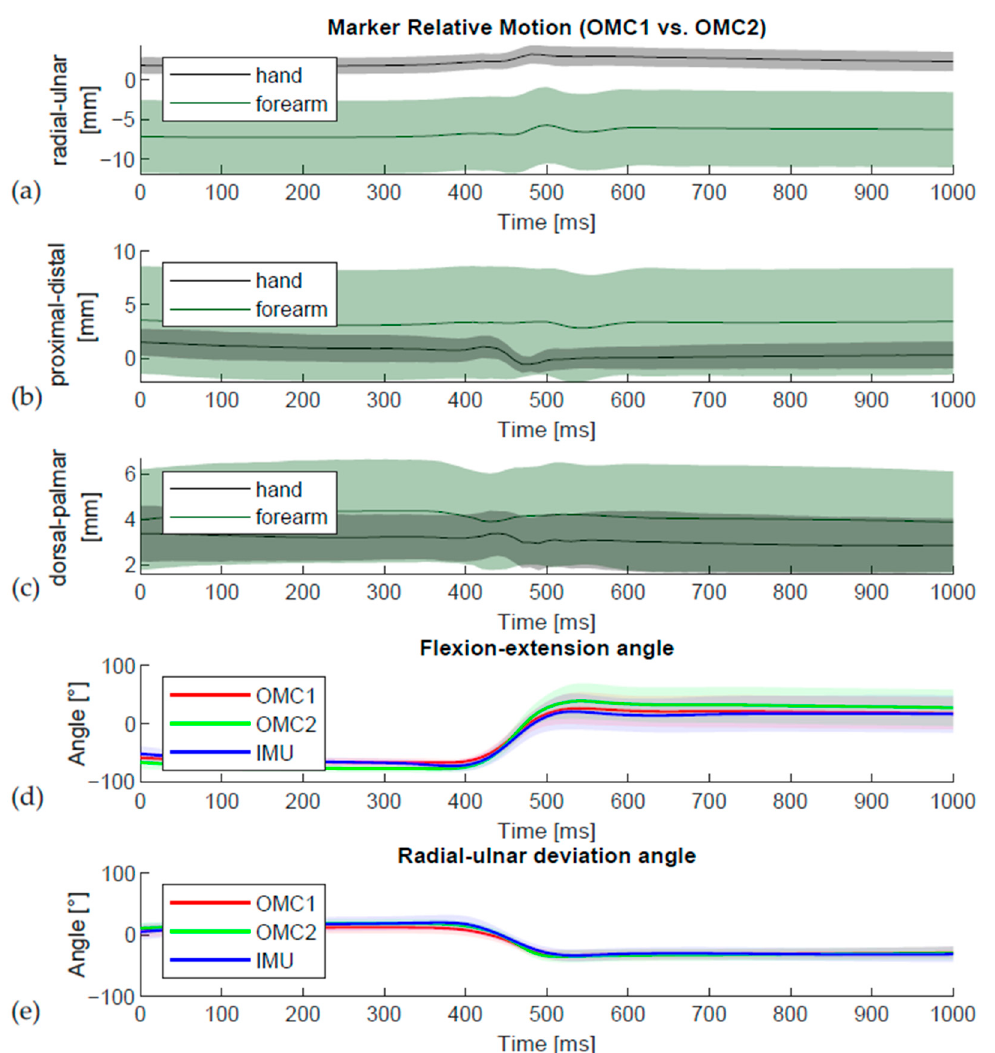
Figure 9. Visual representation of relative movement between the different OMC marker clusters against its reference position in ( a ) radial-ulnar, ( b ) proximal-distal and ( c ) dorsal-palmar direction. The wrist angles during the throw in ( d ) flexion-extension and ( e ) radial-ulnar deviation are displayed for the OMC1 markers in red, OMC2 markers in green, and IMU sensors in blue. A relative movement of the hand and forearm marker clusters of OMC1 and OMC2 was observed ( a – d ), which is associated with the throwing movement.